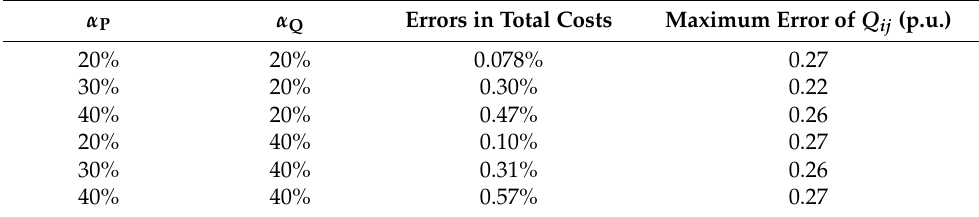
Table 9. Errors of the linearized approximation method at different load variation coefficients. α